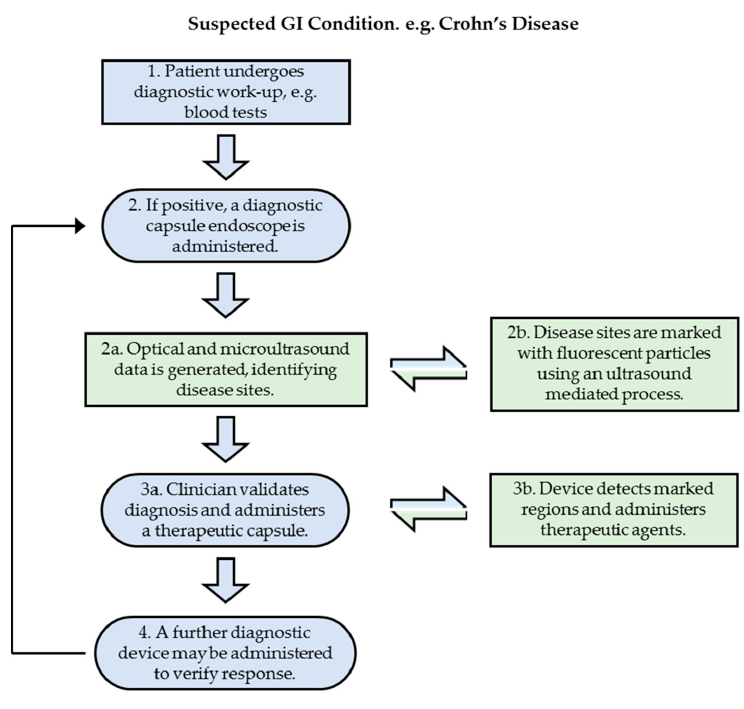
Figure 1. Schematic of the proposed patient pathway. Table 2. Present status of capsules under development and their link to the proposed patient pathway described in Figure 1.